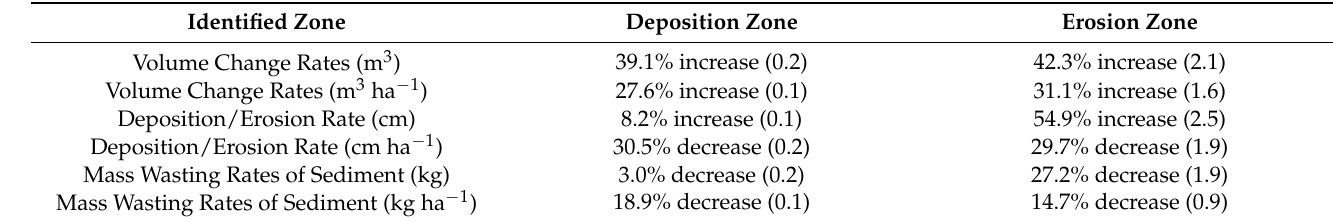
Table 4. Volume change rates, deposition and erosion rates, and sediment mass wasting rates related to soil erosion induced by tillage and reseeding.